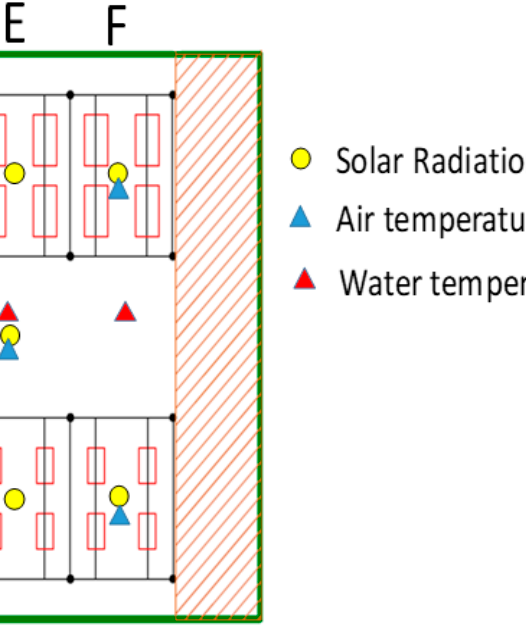
Figure 2. Agrivoltaic layout of the treatments performed at farm A.